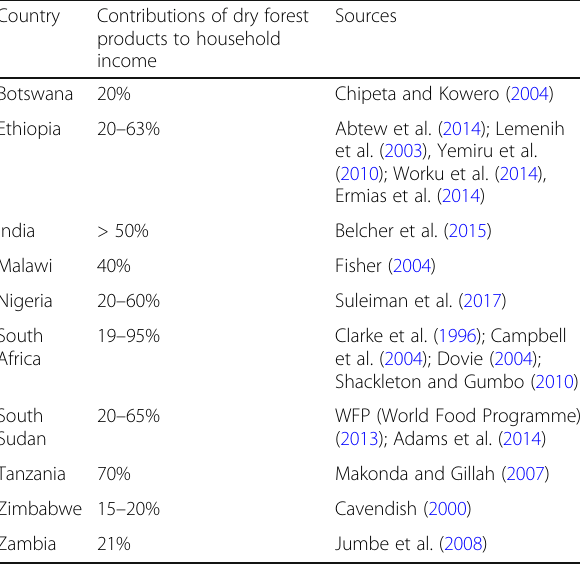
Table 2 Contributions of TDFs to household income, examples from selected case studies Country Contributions of dry forest products to